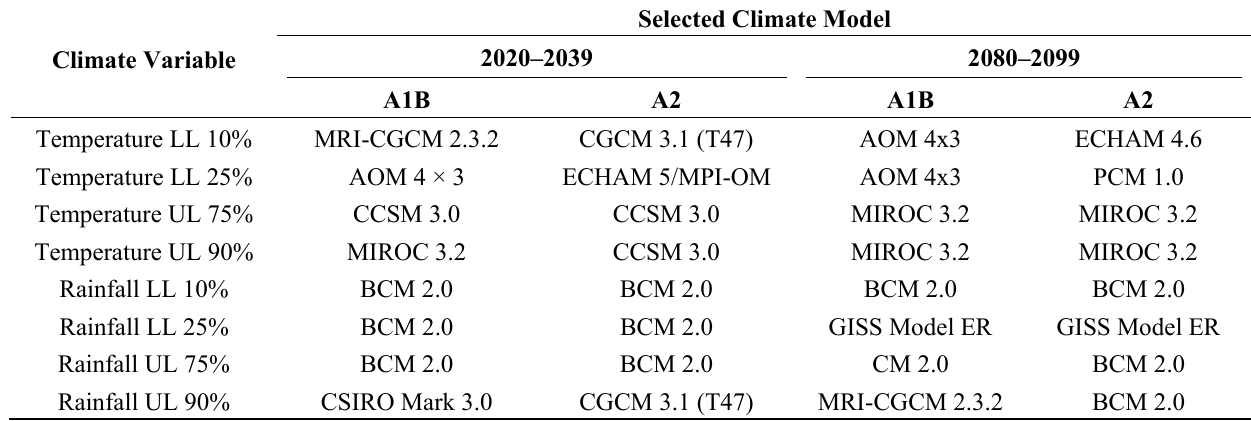
Table 1. Selected AOGCM climate outputs for the simulation of the impacts of climate change on water